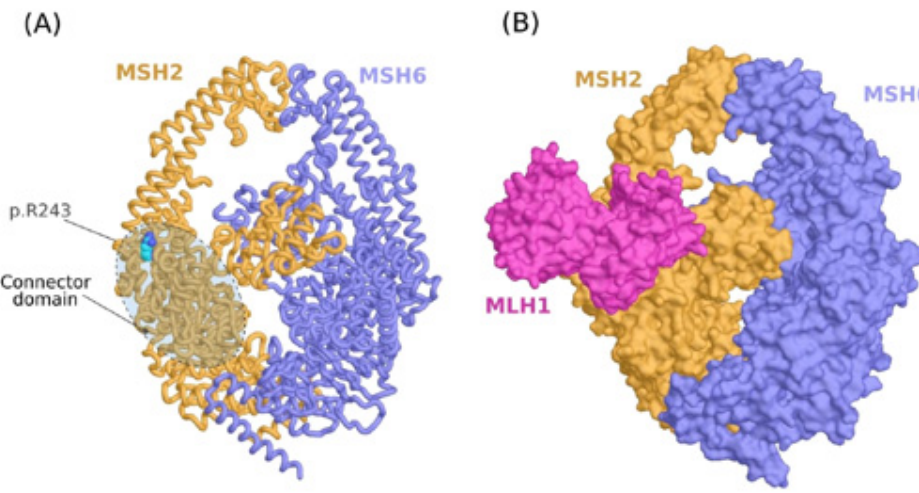
Figure 4. Molecular modeling analysis of p.R243Q variant. ( A ) Molecular model of the MSH2/MSH6 complex showing the location of the variant on the connector domain of MSH2. ( B ) Ternary complex of MSH2/MSH6/MLH1 predicted by protein-protein docking.